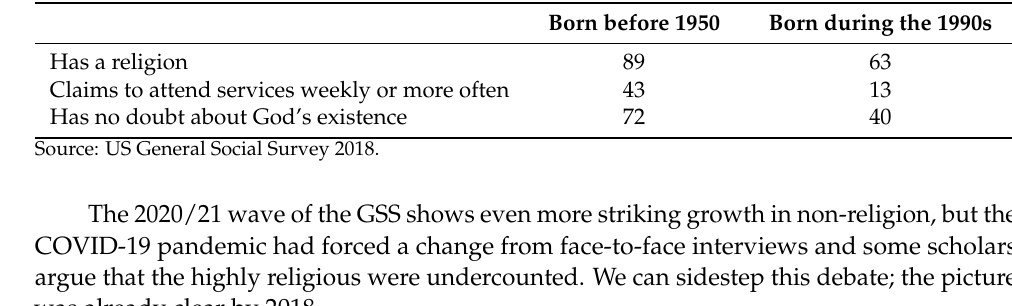
Table 1. The religiosity of old and young Americans in 2018